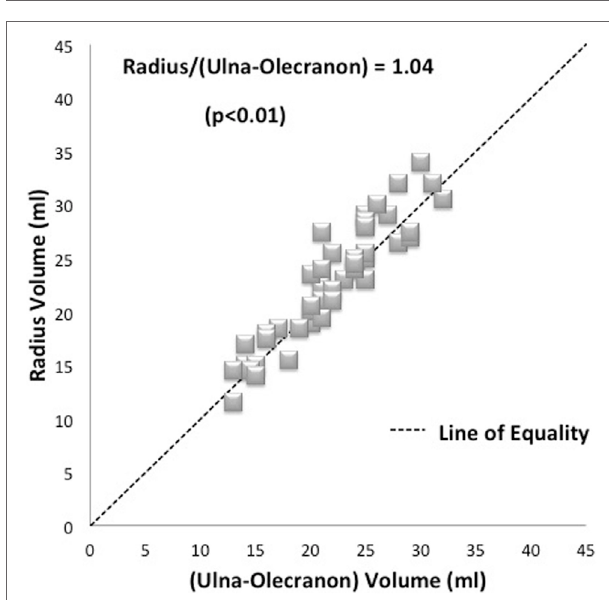
FigUre 4 | Plot of radius and ulna bone volumes where the measured olecranon volume has been subtracted . An average radius to forearm ulna component ratio of 1.04 is shown. Each specimen pair is represented by one dot with several pairs showing as superimposed (diamonds). The line of equality (dashed line) represents the theoretical situation where bone volumes are exactly the same as one another.